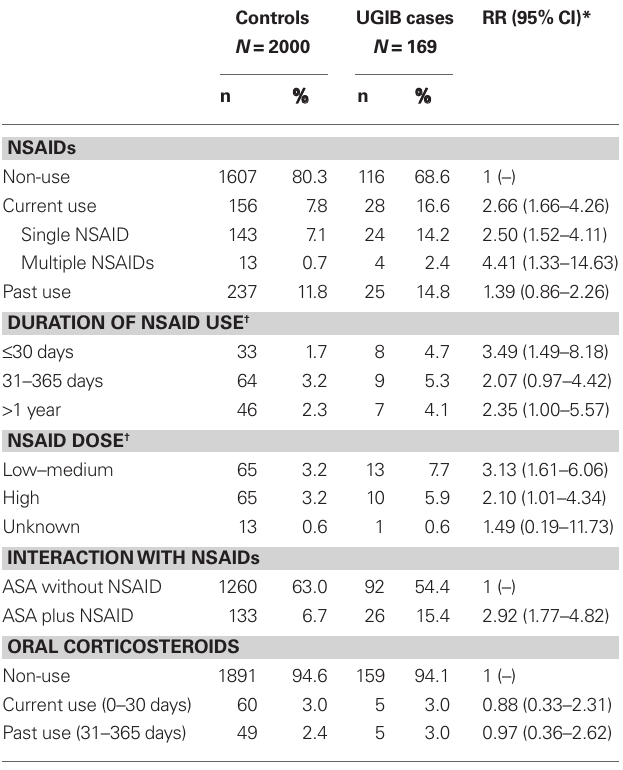
Table 4 | Anti-inflammatory drug use in individuals with ugiB and controls with no ugiB, and its association with a diagnosis of ugiB, in a cohort of low-dose ASA users.